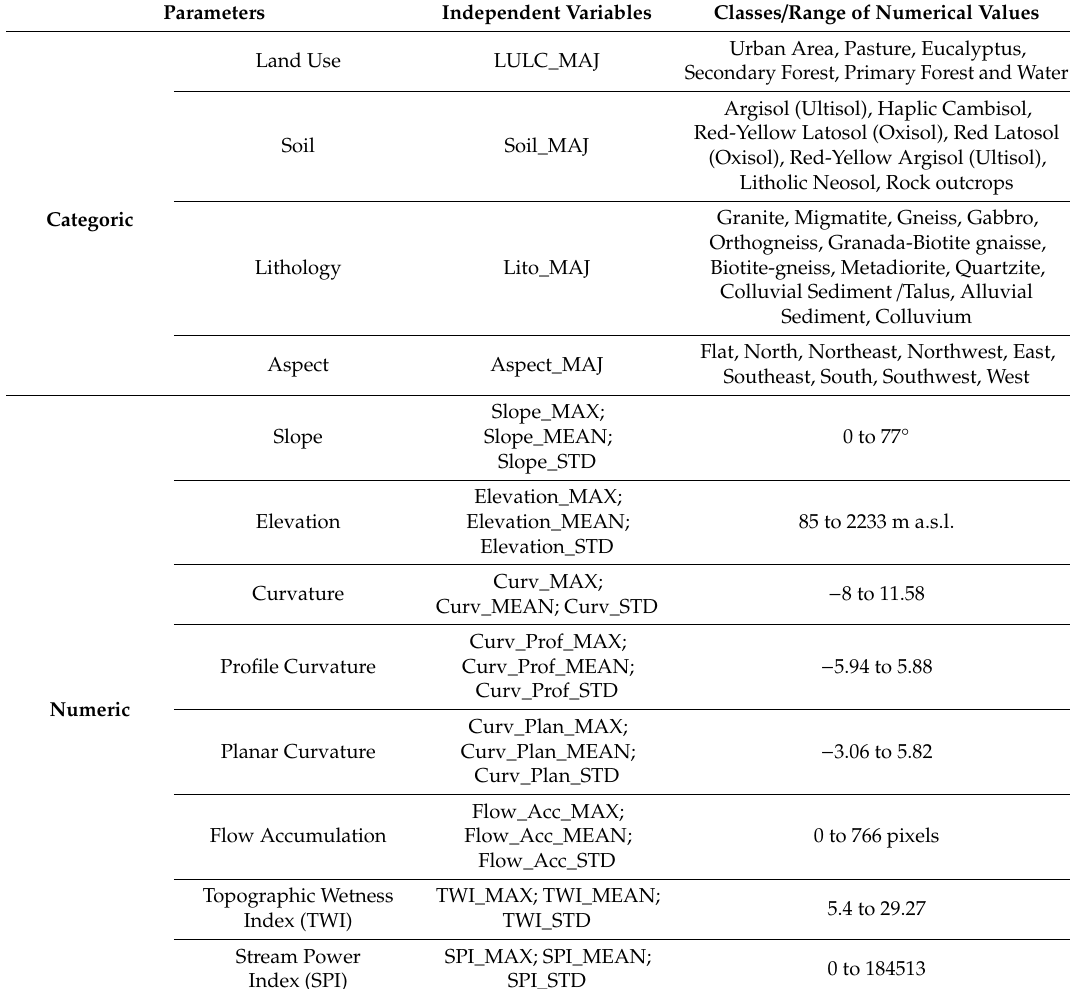
Table 1. The parameters and derived independent variables used in the various configurations of the susceptibility model. Su ffi xes MAJ, MAX, MEAN and STD stand for majority (most represented class), maximum value, mean value and standard deviation,